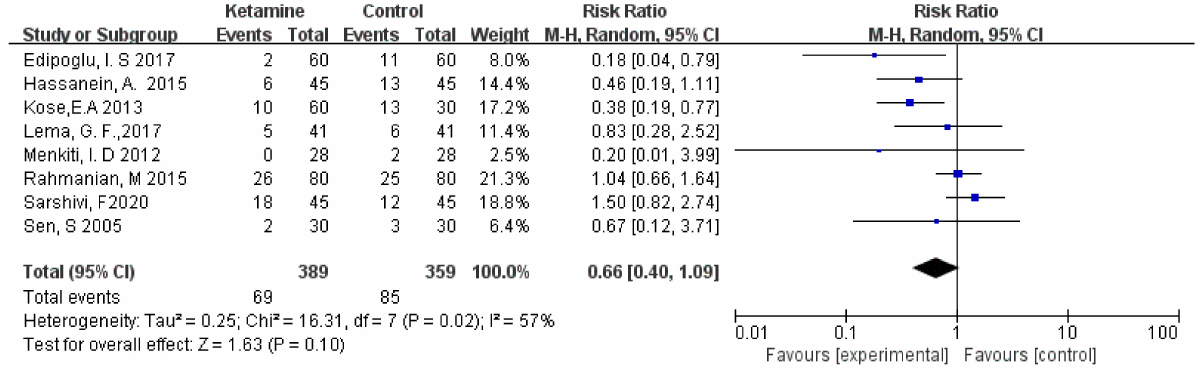
Figure 4. Forest plot of nausea [13–16,19–21,23].